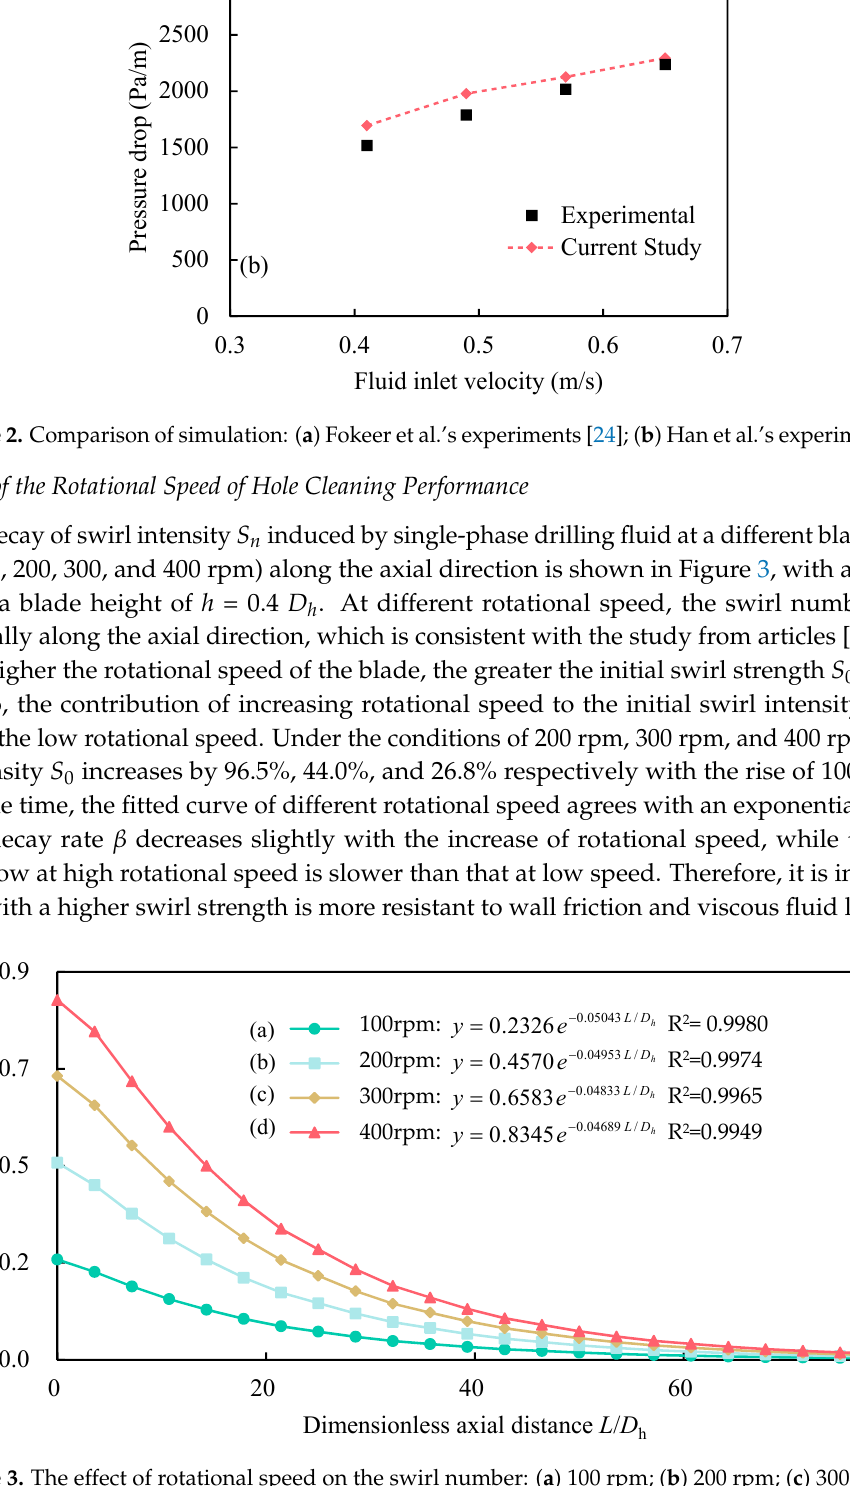
Figure 3. The effect of rotational speed on the swirl number: ( a ) 100 rpm; ( b ) 200 rpm; ( c ) 300 rpm; ( d ) 400 rpm.